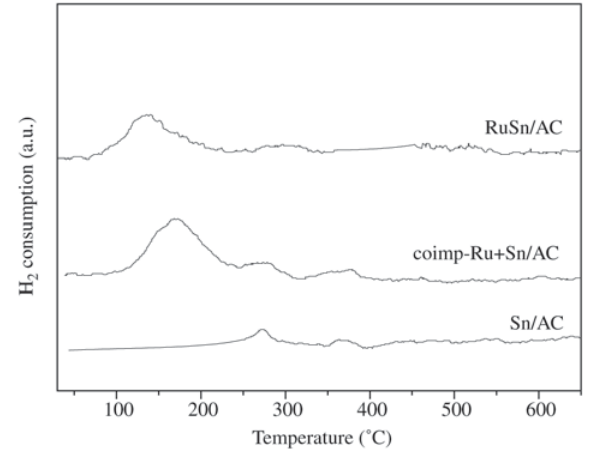
Figure 4. The TPR profiles for the catalysts Sn/AC, co-imp-Ru+Sn/AC and RuSn/AC.